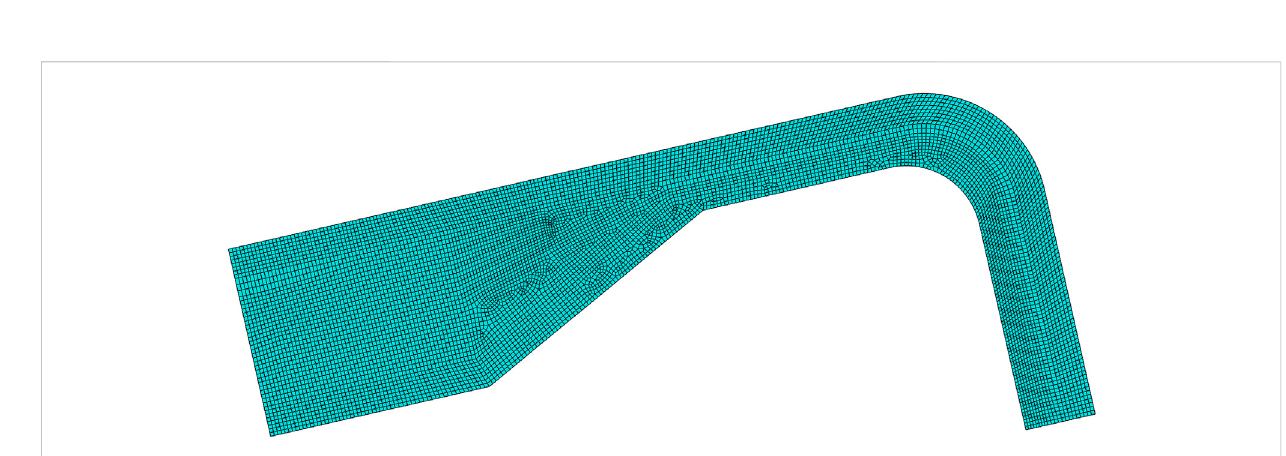
FIGURE 2 Mesh used for cure simulation in